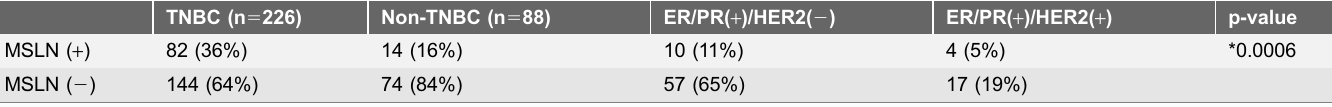
Table 3. MSLN correlates significantly with TNBC